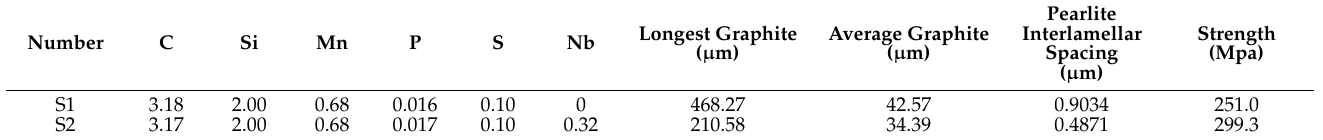
Table 4. The composition as well as strength of tensile test samples (% by